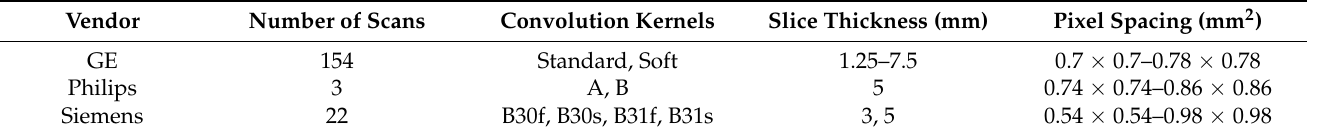
Table 1. Description of the data